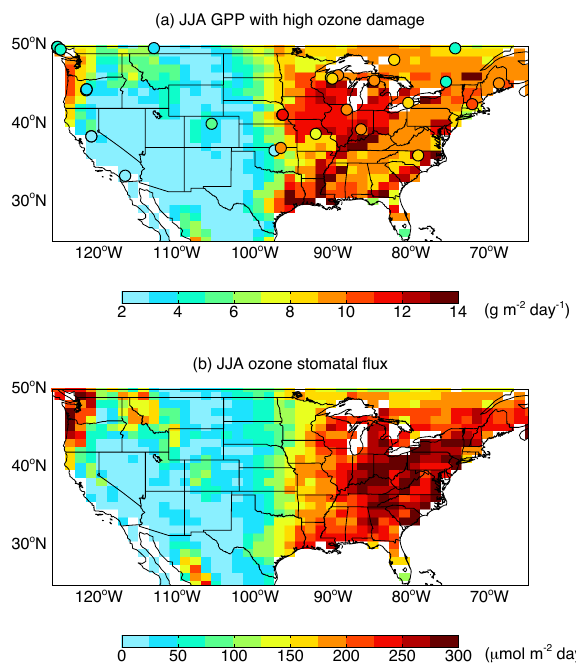
Figure 7. Simulated summertime (a) O 3 -exposed GPP and (b) O 3 Fig. 7. Simulated summertime (a) O 3 -exposed GPP and (b) O 3 stomatal flux over the U.S. 1157 stomatal flux over the US. The simulated GPP is overlaid with The simulated GPP is overlaid with in situ measurements from NACP. The simulations 1158 in situ measurements from NACP. The simulations are performed are performed with land cover from ISLSCP and meteorological forcings from MERRA 1159 with land cover from ISLSCP and meteorological forcings from reanalysis. Fig. S8 separates results for model and measurements. 1160 MERRA reanalysis. Figure S8 in the Supplement separates results for model and measurements.